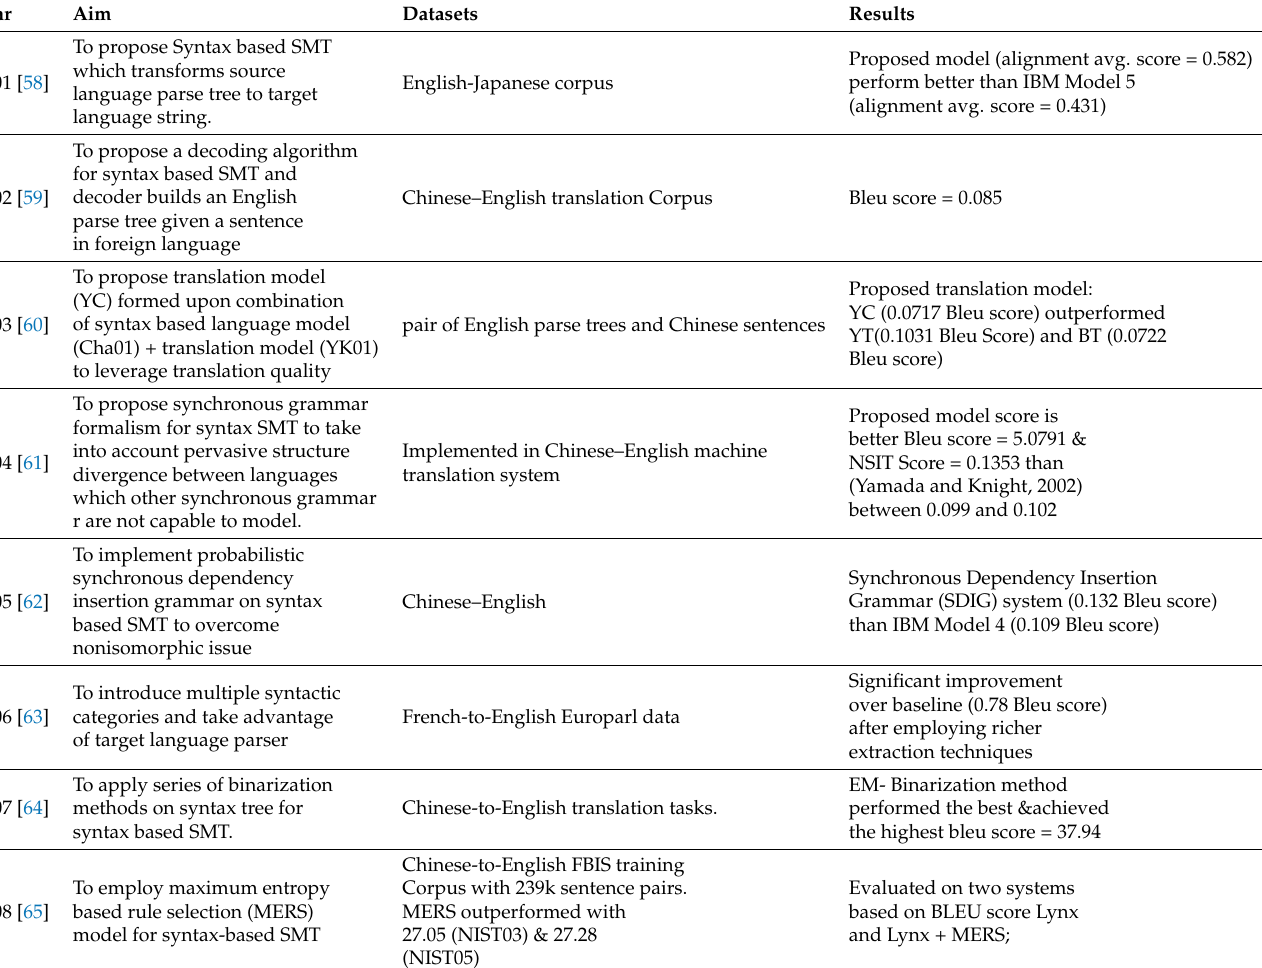
Table 3. Survey for Syntax based machine